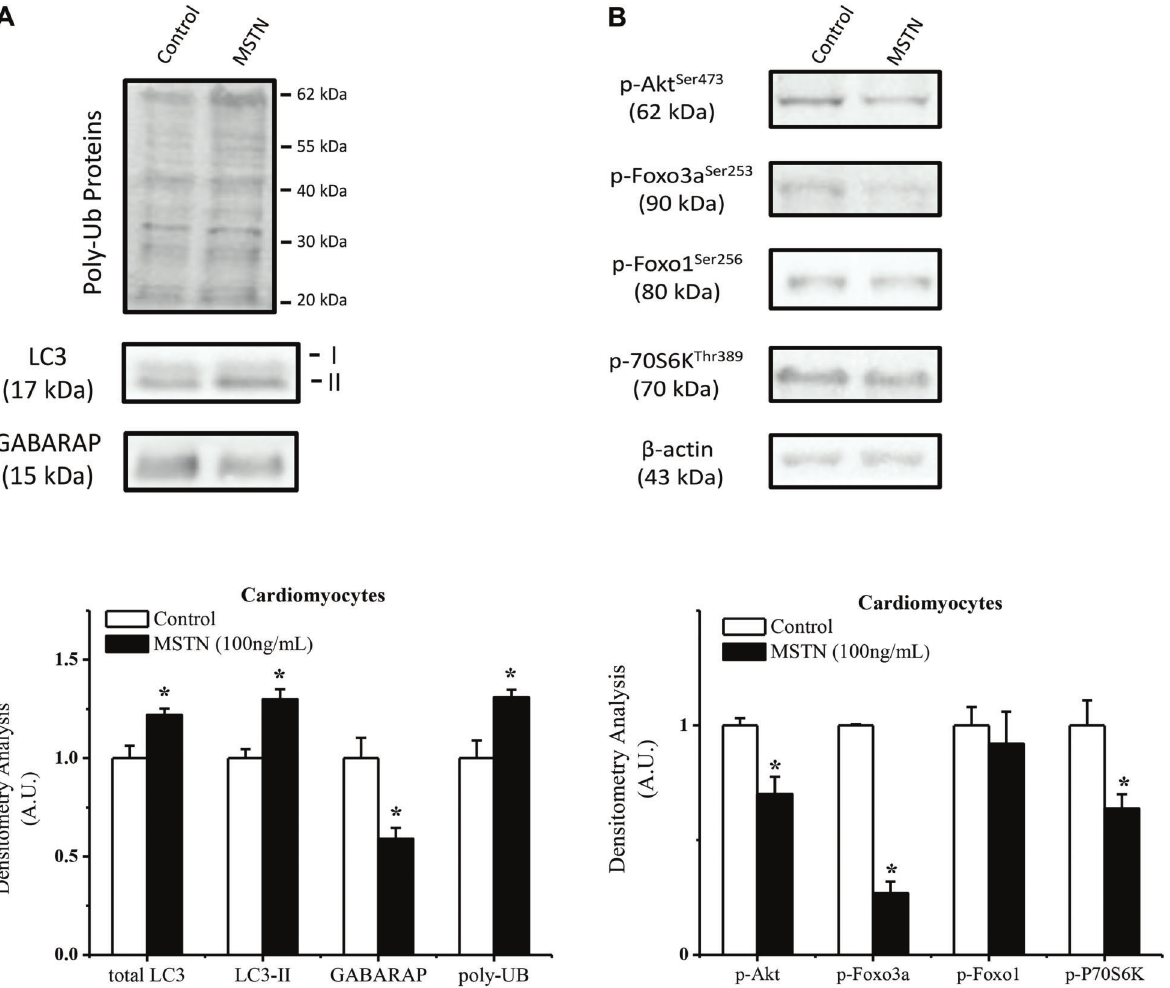
Figure 5. A , Protein content of ubiquitinated (UB) proteins, total LC3 and form II, and GABARAP from cardiomyocytes incubated with myostatin (MSTN) (100 ng/mL) for 24 h with densitometry analysis of these proteins corrected to b -actin. Control was considered to be 1. Data are reported as means ± SEM (n=5). B , Phosphorylation status of Akt, FoxO3a, FoxO1, P70S6K in cardiomyocytes incubated with myostatin for 24 h with densitometry analysis of these proteins corrected to their respective total proteins. Control was considered to be 1. Data are reported as means ± SE (n=5). *P o 0.05, t